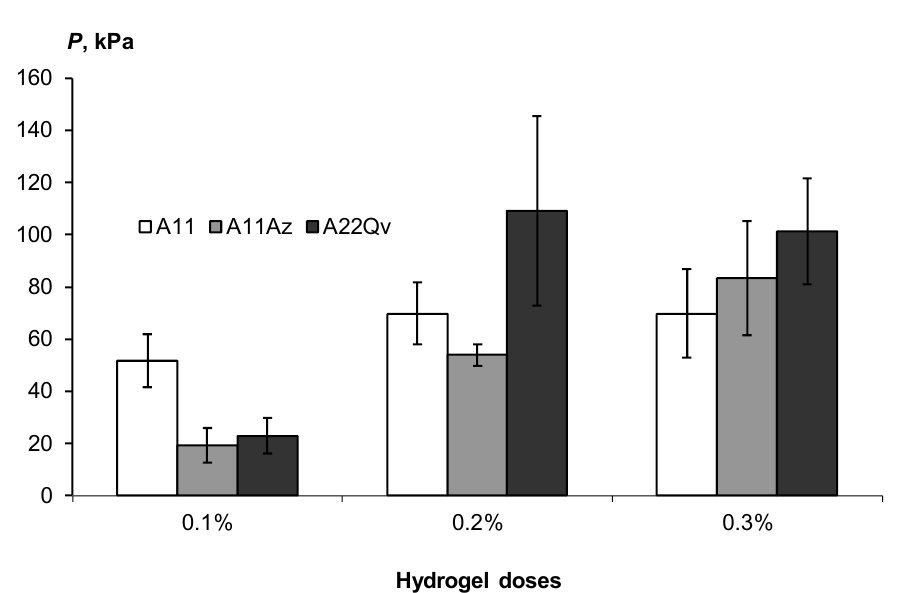
Figure 12. Strength of soil aggregates depending on the dose of gel-forming conditioners.